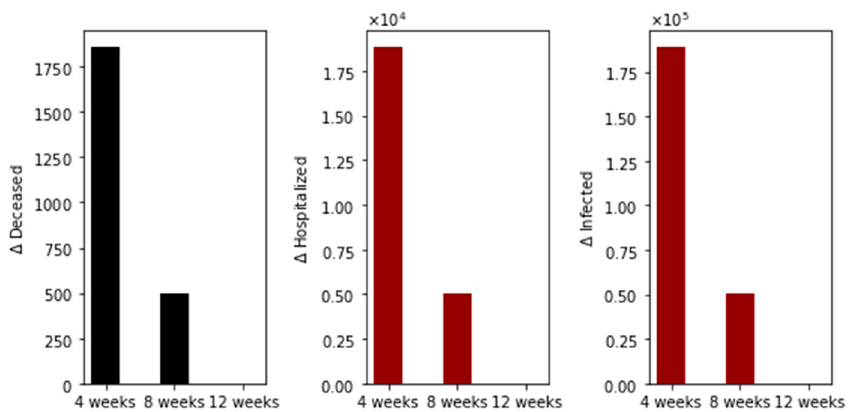
Figure 4. Differences in the total number of deaths, hospitalized and infected, under the different time interval vaccine regimens. This scenario considers a transmission rate such that the basic reproduction number R 0 is less than one, the vaccination pace is 2 million per day, and the vaccine efficacy after the first dose is 60% and 95% after the second dose.